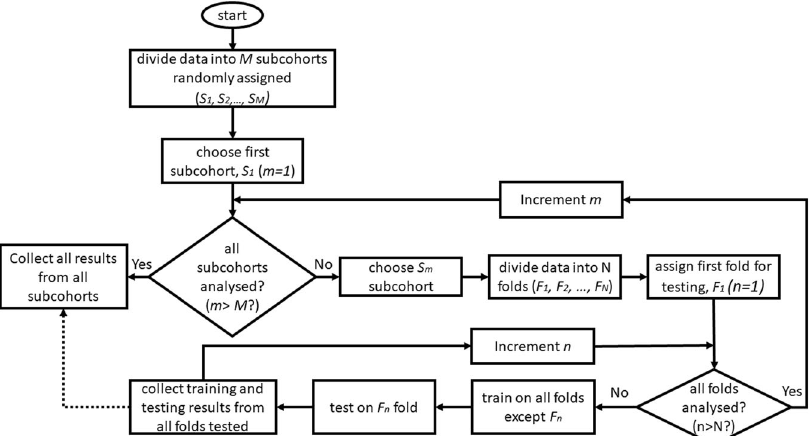
Fig. 2 Overview of study methods. Overall fl ow diagram illustrating how subcohorts were created and how k-fold cross-validation was used for internal validation. In this study, M was chosen to be 8, and N was chosen as